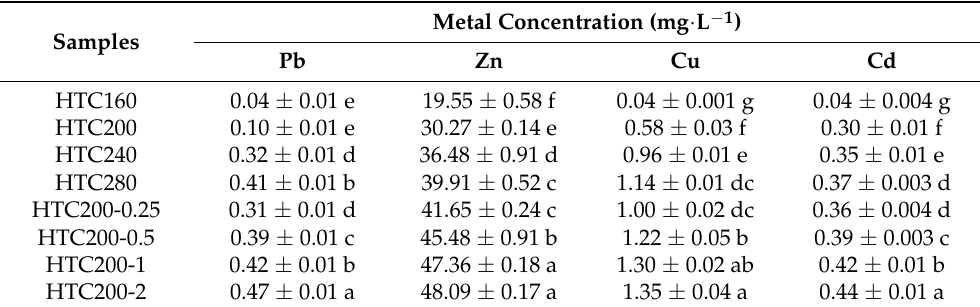
Table 2. The concentration (mg · L − 1 ) of heavy metals in liquid products formed by HTC at different